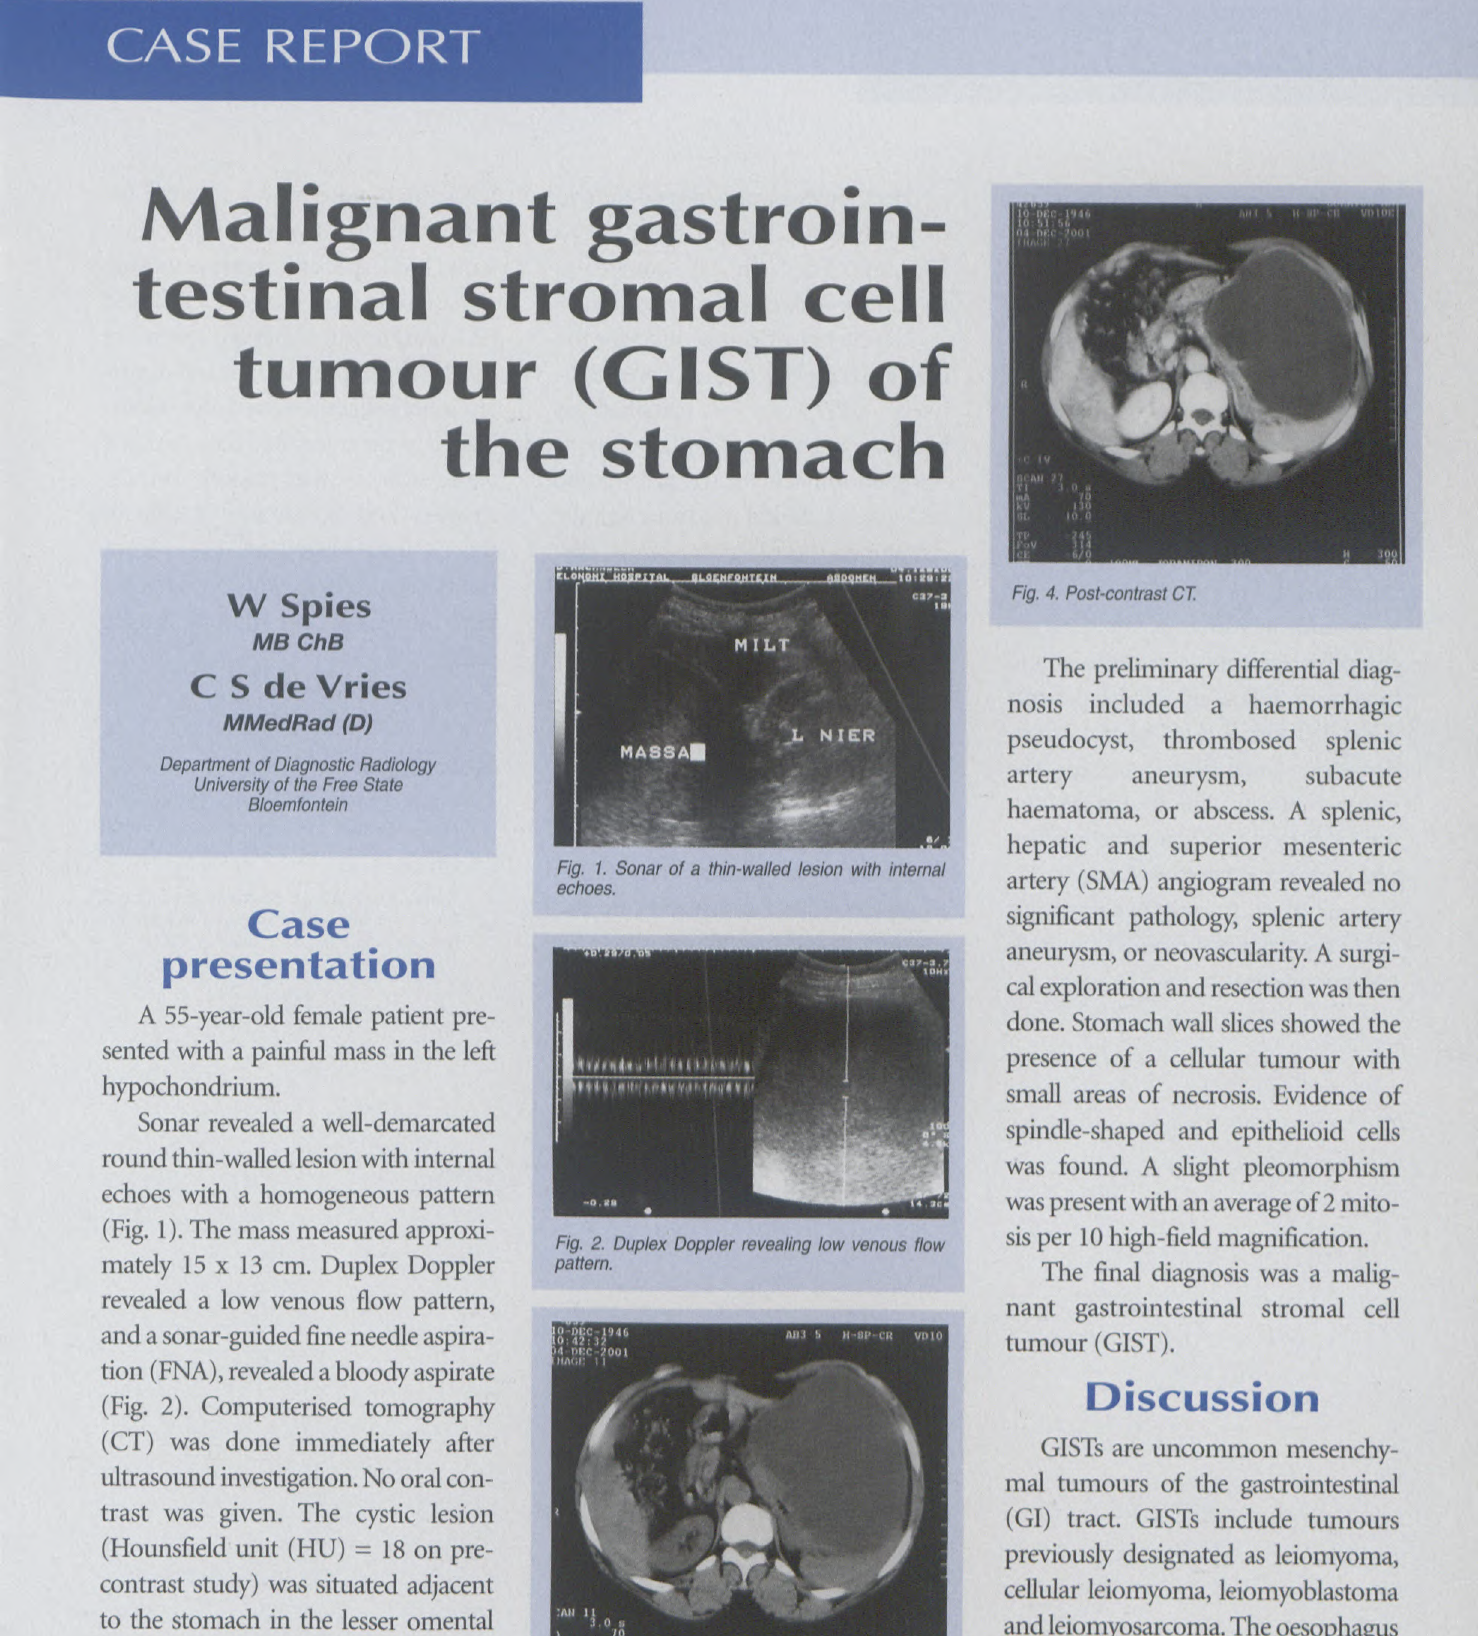
Fig. 3, Pre-contrast CT.